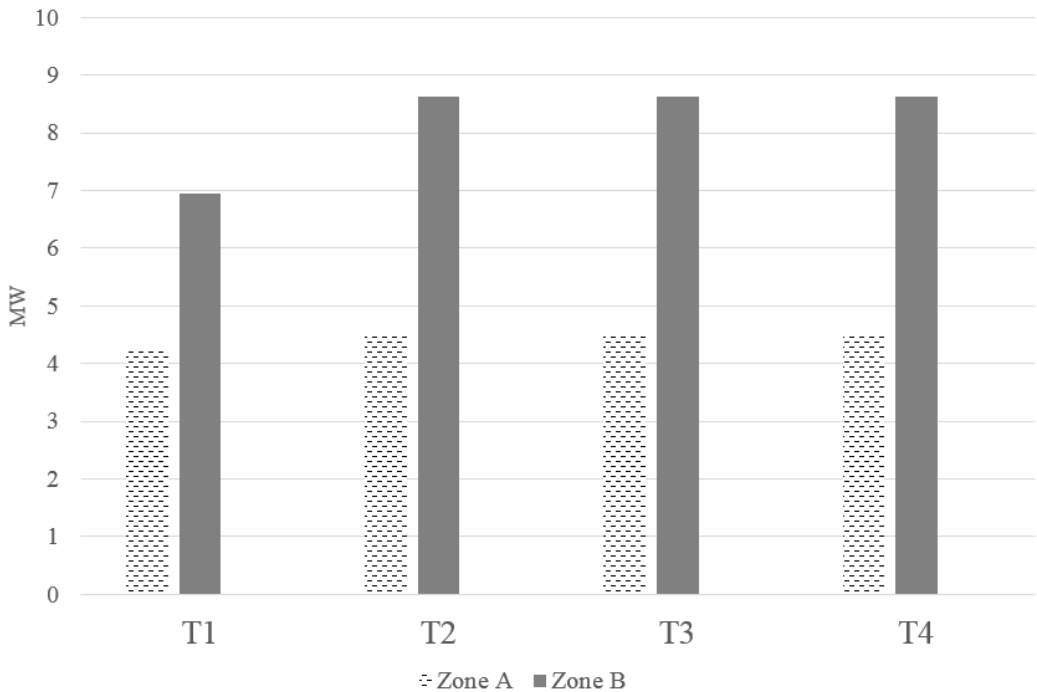
Figure 4. Number of parked EVs for an EV market penetration rate of 1%.